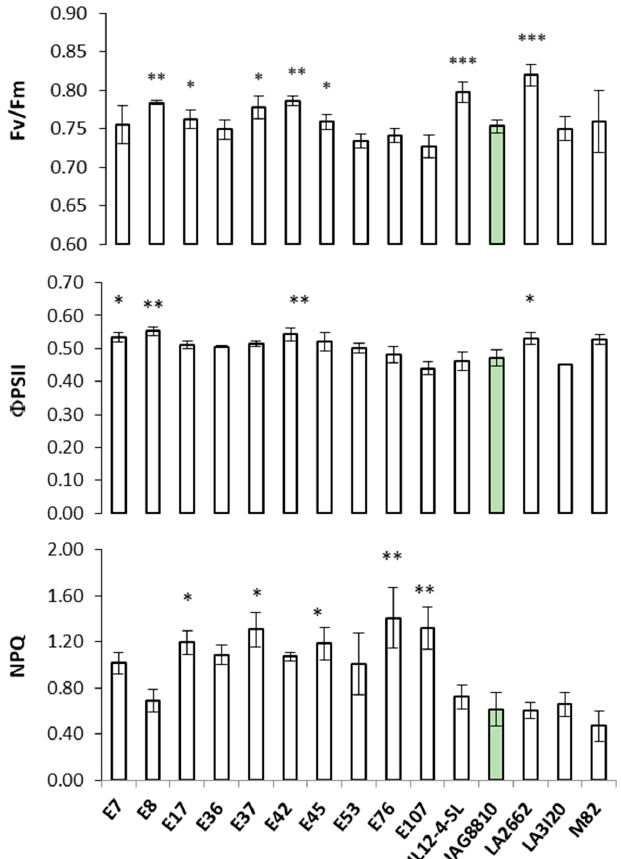
Figure 1. Maximum quantum yield of photosystem II (PSII) (F v /F m ), effective quantum yield of PSII ( Φ PSII ), and non-photochemical quenching (NPQ) measured on different tomato genotypes grown under a plastic walk-in tunnel. Bars are means ± standard error ( n = 5). ANOVA with LSD post-hoc test was used to compare each genotype vs. the control genotype JAG8810 (green column). The asterisks indicate statistically significant differences at * p < 0.05; ** p < 0.01; *** p < 0.001. Table 2. Pearson’s correlations between physiological parameters, pigment content and crop